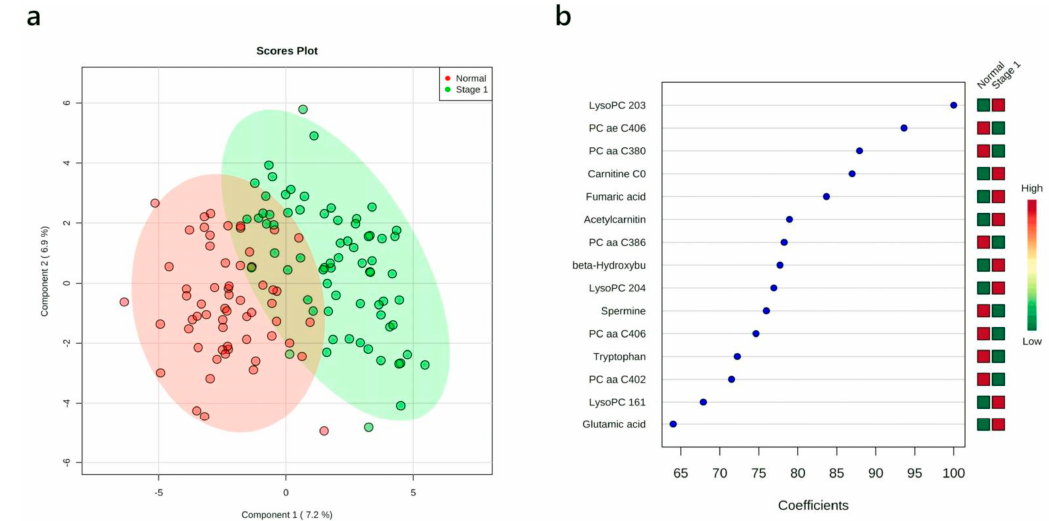
Figure 1. Partial least squares discriminant analysis (PLS-DA) results showing the comparison between plasma metabolite data acquired for healthy controls vs. stage I non-small cell lung cancer (NSCLC) patients. ( a ) 2-D PLS-DA scores plots; ( b ) variable importance in projection plot. The most discriminating metabolites are shown in descending order of their coe ffi cient scores. The color boxes indicate whether metabolite concentration is increased (red) or decreased (green) in controls vs.